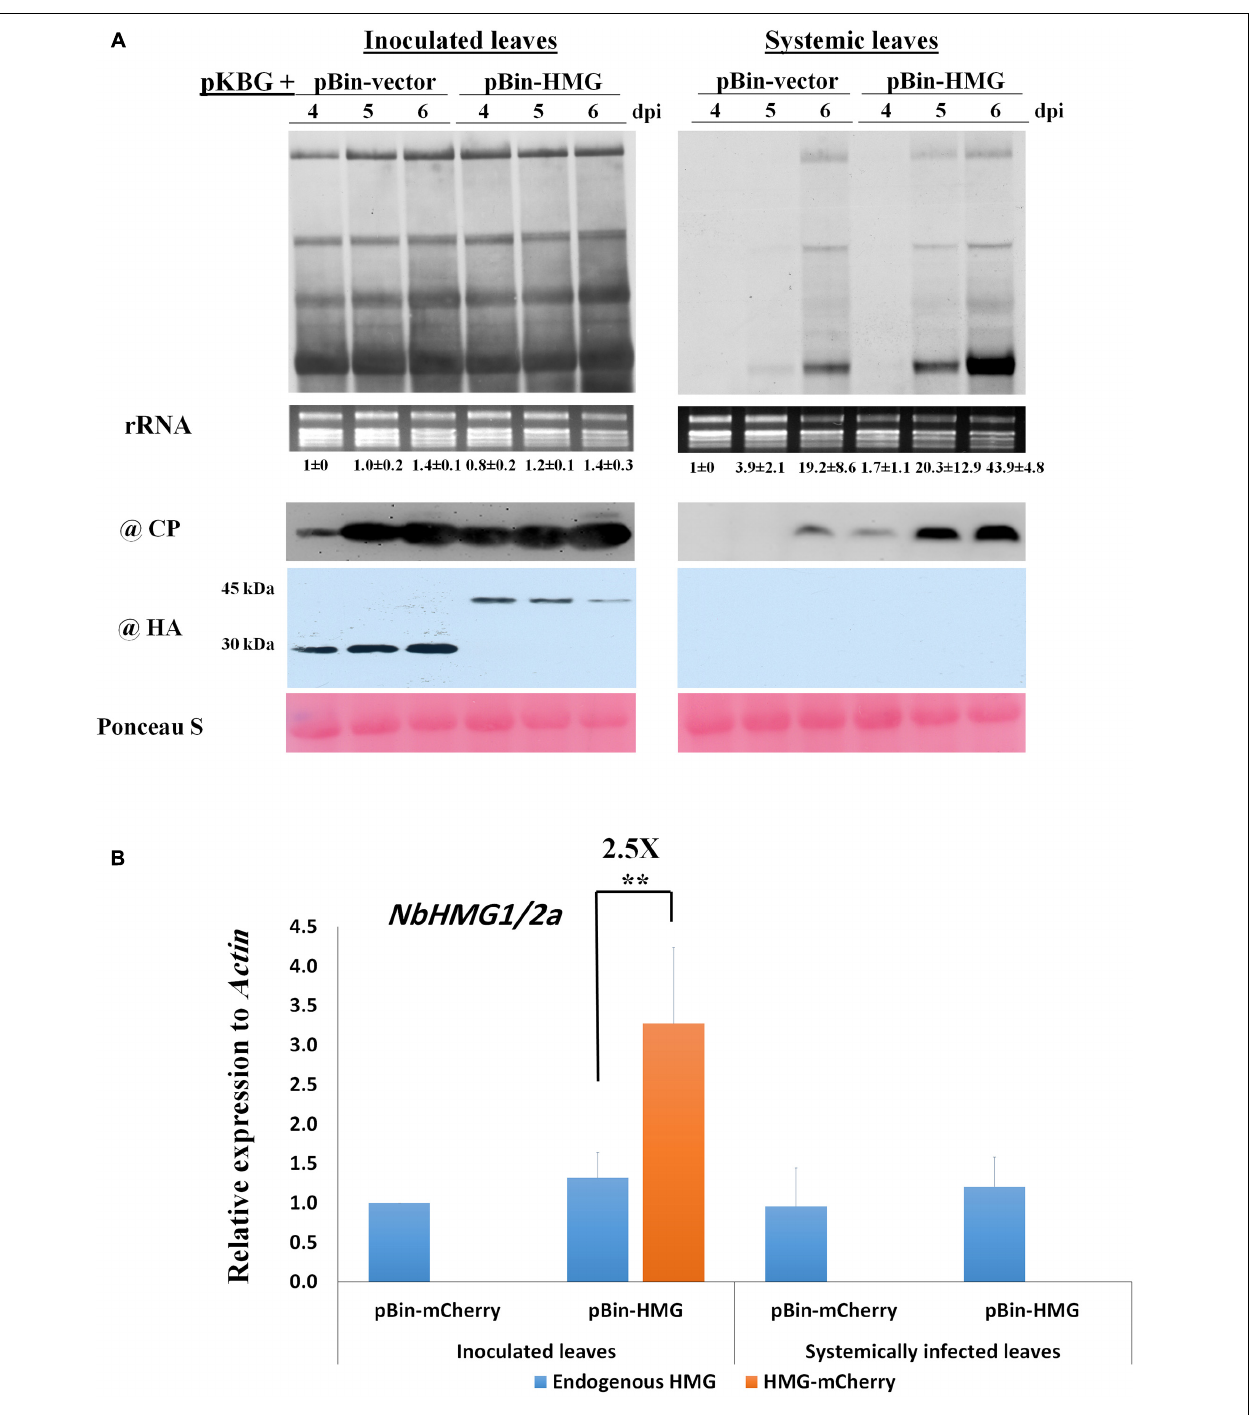
FIGURE 4 | Overexpression of NbHMG1/2a enhances systemic movement of BaMV. (A) Twenty-four-day-old N. benthamiana plants were co-agroinfiltrated with pKBG and pBin-HA-mCherry or pBin-HA-mCherry-HMG. Samples were collected from inoculated and systemic leaves at 4, 5, and 6 dpi. Upper panels are Northern blots for BaMV, with rRNA used as a loading control. Lower panels are protein blots of BaMV CP and HA-tag to detect HA-mCherry (30 kDa) and HA-mCherry-HMG (45 kDa). Ponceau S was used as a loading control. The experiment was conducted with three biological replicates, which generated similar results. Values below Northern blots represent average accumulation of BaMV genomic RNA from three biological replicates ± SD. (B) Relative expression of endogenous NbHMG1/2a and the overexpressed gene NbHMG1/2a-mCherry in inoculated and systemic leaves of NbHMG1/2a -overexpressing plants based on RTqPCR. According to one-sided student t- test, asterisk indicates significant difference for the expression of NbHMG1/2a-mCherry relative to the endogenous NbHMG1/2a , with ** representing P < 0.01. Actin was used as an internal control. Error bars represent the standard deviation from three biological replicates.